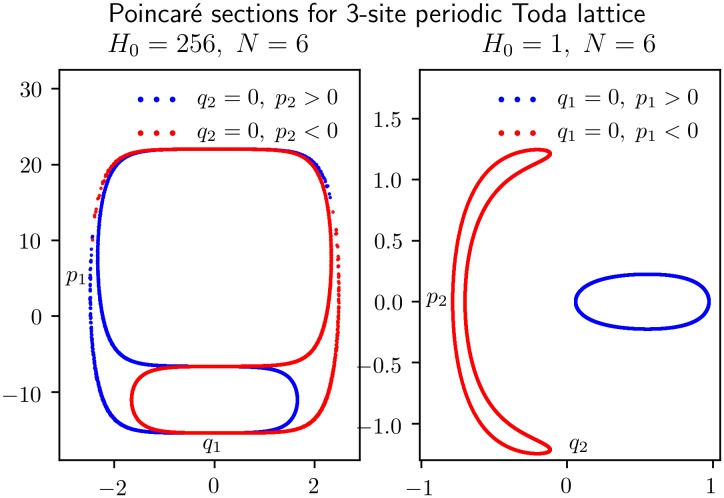
Poincaré sections for an orbit of the reduced 3-site Toda lattice model of Eq (11).Each panel shows 4000 crossings of the (q2 = 0)-plane, 2000 in the positive direction (p2 > 0, marked blue), and 2000 in the negative direction (p2 < 0, marked red). The dynamics between each crossing is determined by a KiMoKi solver of order 6, with timestep τ = 0.01. The initial condition is z0 = (1, 0, 22, 5.04993), with H0 = 256, C3⊥ = 72099.45264, for the left panel, and z0 = (0, 0.1, 1.40733), with H0 = 1, C3⊥ = 23.51188 for the right panel.